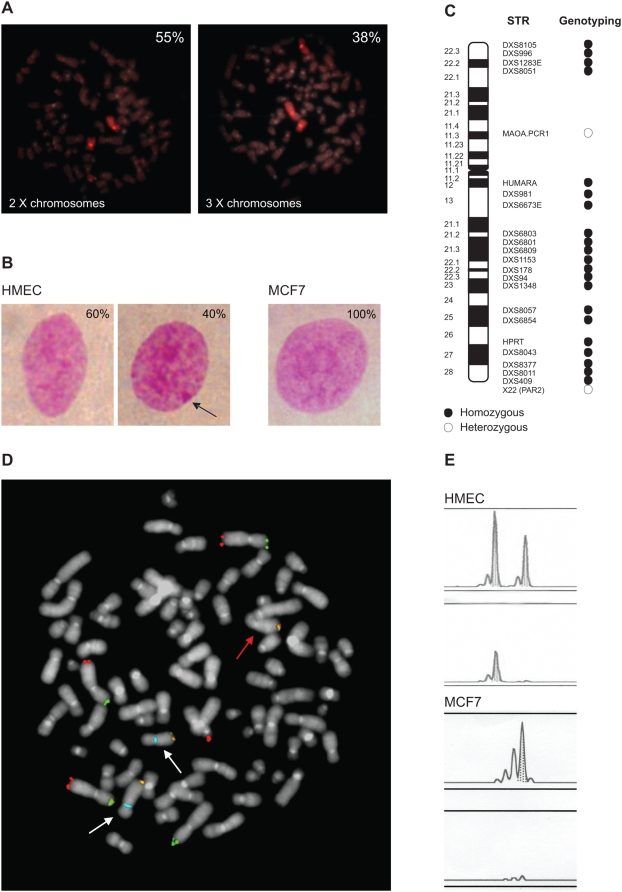
X chromosomes characterization of MCF7 cell line.A) FISH analysis on metaphases using X painting probe. The percentages of MCF7 cells with two (left) or three (right) X chromosomes are indicated. B) Barr body staining. The percentages of HMEC, used as positive control, with (right) or without (left) a detectable Barr body (arrow) are indicated. No positive cell was observed in MCF7. C) High level of homozygosity (87%) detected by genotyping of the indicated panel of STRs. D) DNA FISH using a mix of telomeric (red, green and orange) and X alpha-satellite (blue) probes. The orange spots decorate the Xq telomeric region: two on X chromosomes, positive for X-alpha satellite probe (white arrows) and one on a rearranged chromosome, negative for X-alpha-satellite probe (red arrow). Telomeric red and green probes were used as hybridization control. E) Methylation analysis of ZMYM3 gene subjected to XCI (DXS6673E locus). Electropherograms show the allelic patterns obtained by PCR of HMEC and MCF7 DNAs undigested (top) and digested with methylation-sensitive enzymes (bottom). After digestion, HMEC show a methylated allele, whereas in MCF7 the locus is completely demethylated, resulting in the lack of amplification.